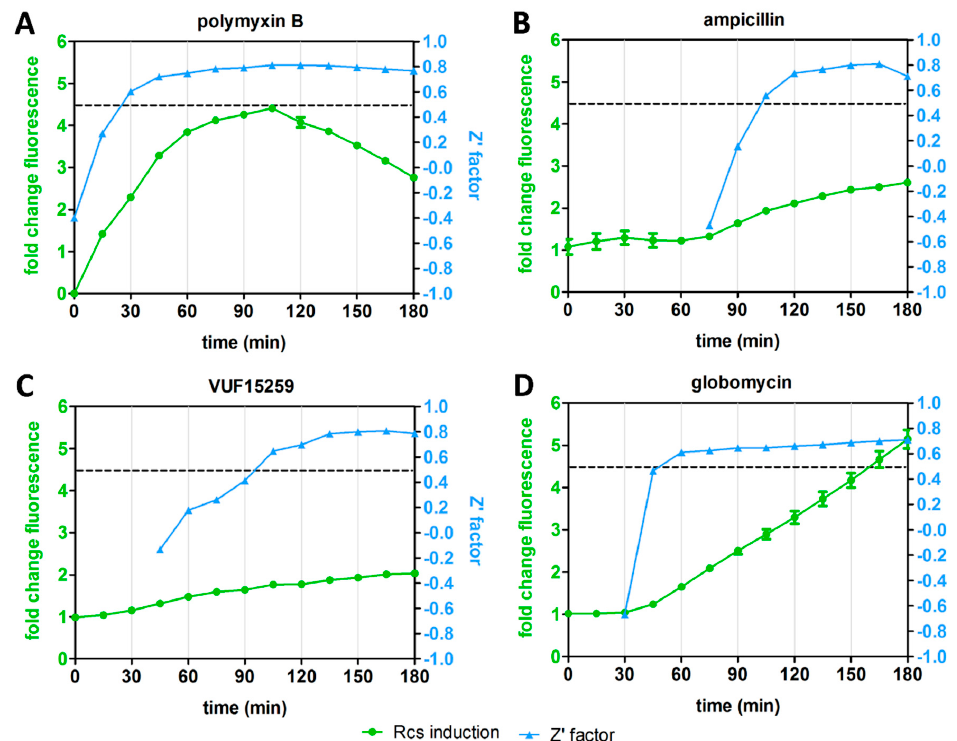
Figure 4. Rcs reporter assay reliability for HTS (high-throughput screening). E. coli TOP10F’ cells, harboring the P rprA -mNG reporter construct, were grown in a 96-well plate. The cells were either treated with an antibiotic at 0.5 × MIC (positive control) or not treated (negative control) in an interleaved-signal format. By measuring the OD 600 -corrected mNG fluorescence plotted as fold-change compared to untreated cells (set to 1), the Z’ factor of the reporter assay was determined at multiple time points for ( A ) polymyxin B (PMB), ( B ) ampicillin ( C ) VUF15259 and ( D ) globomycin. The Z’ factor could not be calculated at early time points for some of the antibiotics (ampicillin, globomycin and VUF15259). The dashed line indicates a Z’ factor of 0.5. Error bars represent the standard deviation of triplicate samples. The figure shows a representative example of three independent